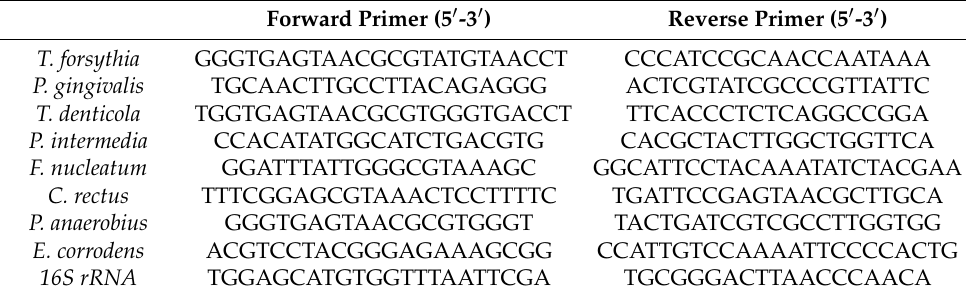
Table 2. The primers used in this study. Forward Primer (5 (cid:48) -3 (cid:48)